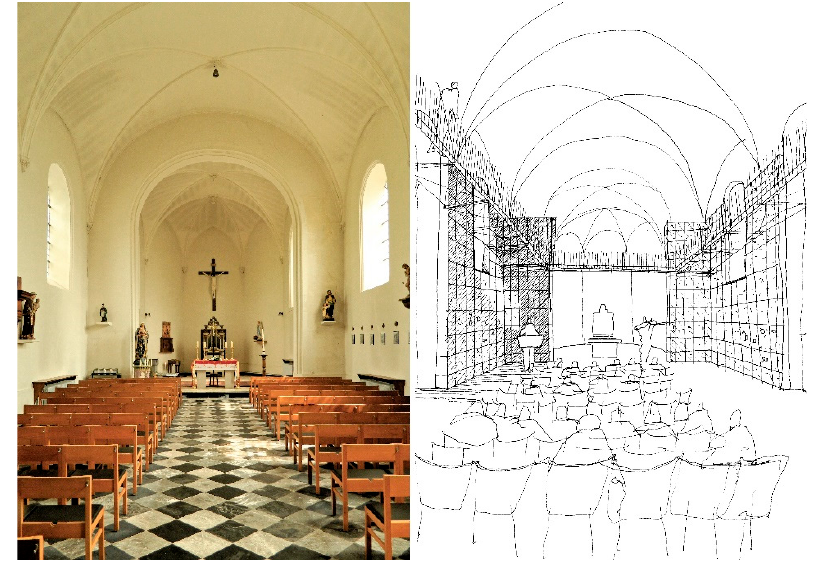
Figure 2. Left: view of the current interior of the St. Odulphus church; right: a sketched impression of the transformation into a columbarium church (hand drawing by Saidja Heynickx).